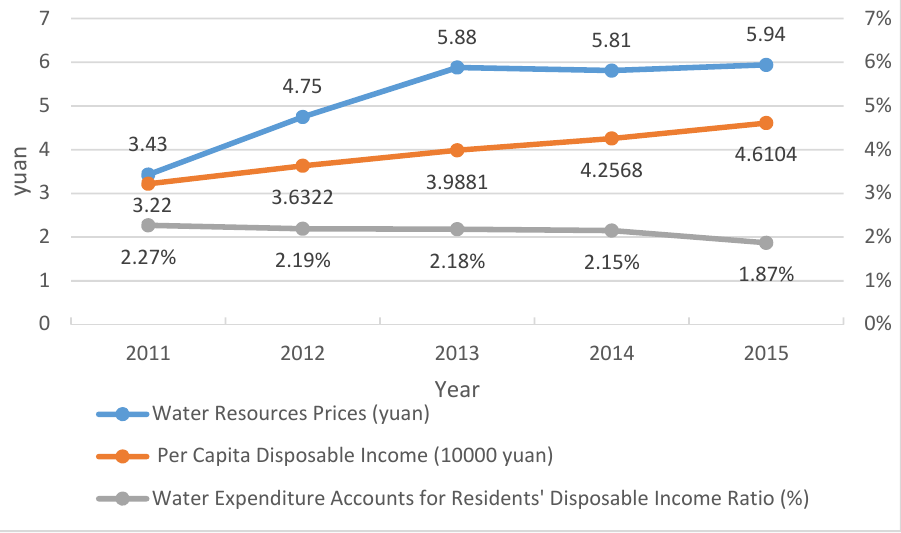
Figure 2. Water resource prices and per capita disposable income trends 2011–2015.